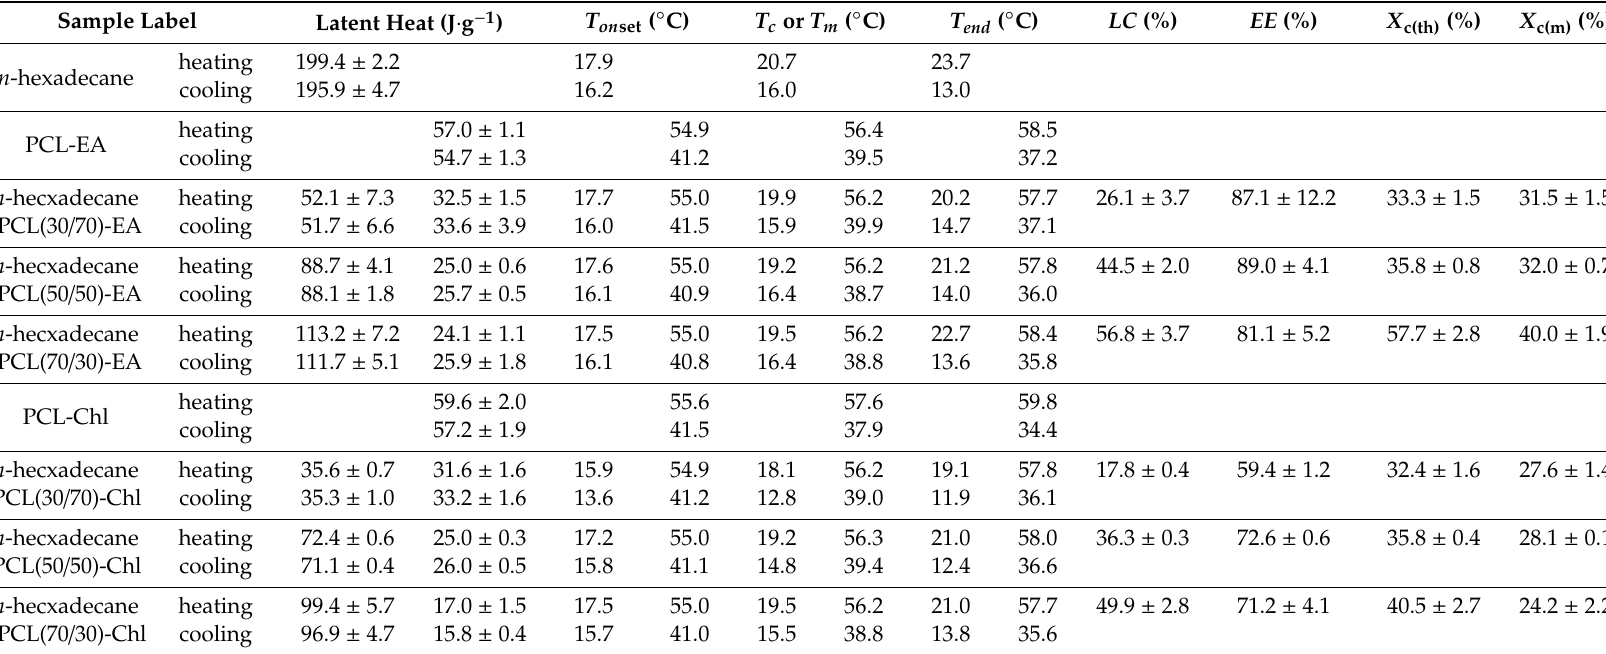
Table 1. Thermal properties of n -hexadecane, neat poly(caprolactone) (PCL) microspheres and a series of n -hexadecane / PCL microcapsules obtained from ethyl acetate and chloroform solutions at three weight ratios between n -hexadecane and